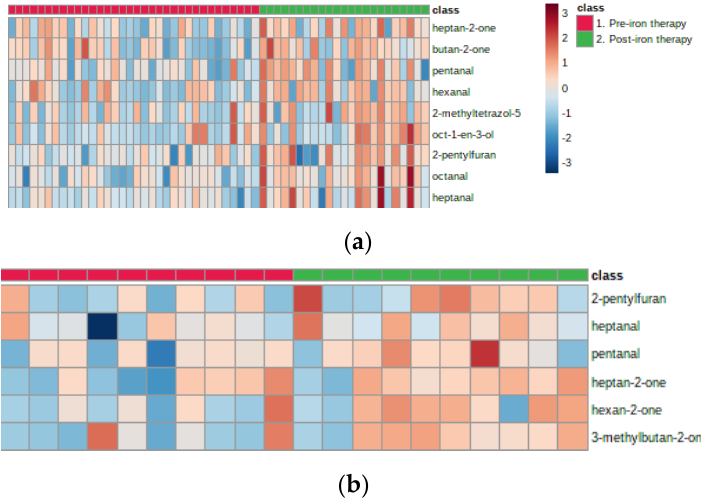
Figure 1. Heatmaps to show the increase in volatile organic compounds (VOCs) with iron therapy in Group 1 ( a ) and Group 2 ( b ).